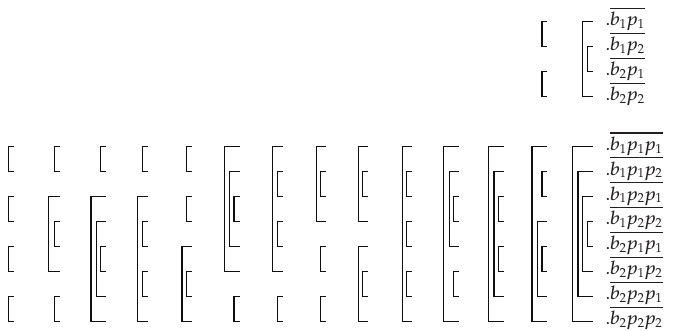
Figure 1: Possible coupling patterns in the first and second levels .b ∗ p ∗ and .b ∗ p ∗ p ∗ corresponding to the noncentral BMSs in a multiple-spiral